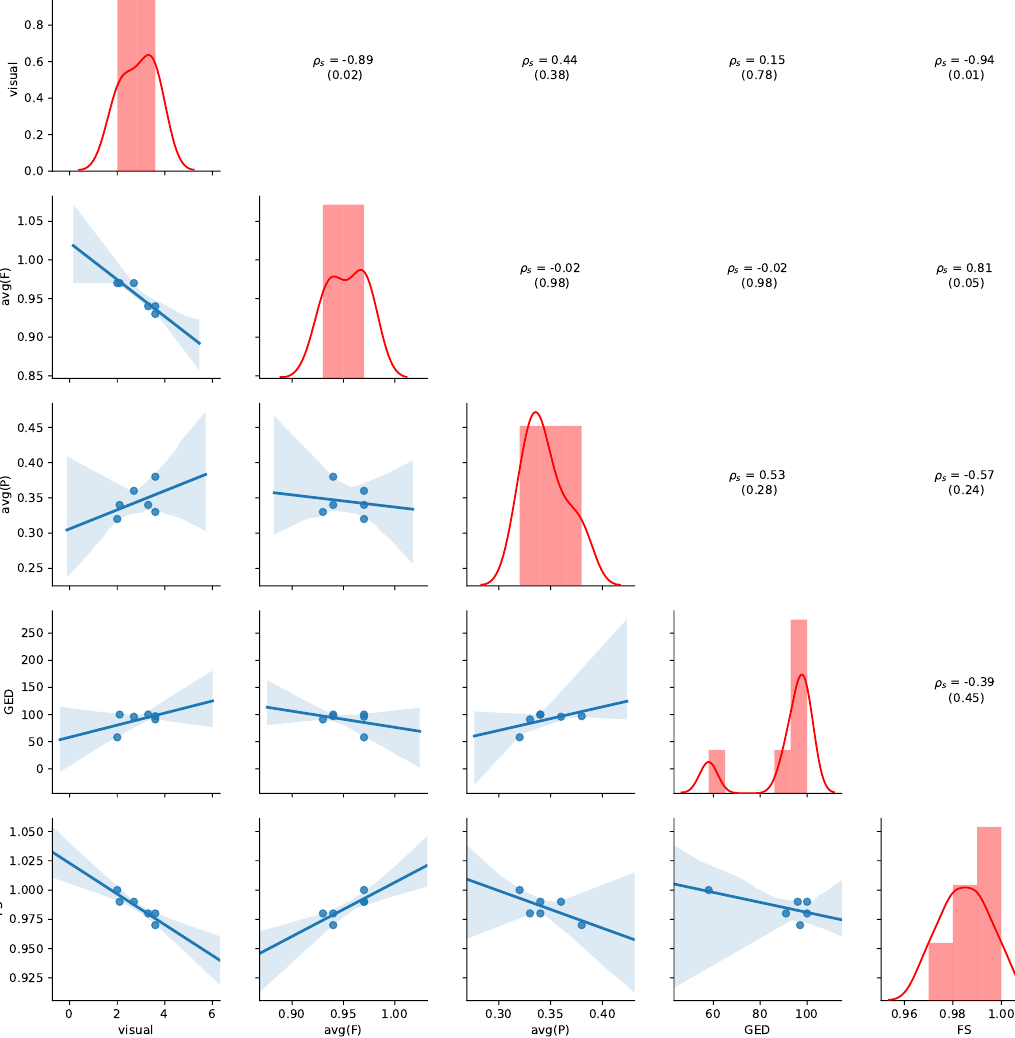
Figure 6. Relation of aggregated measures for MIMIC. Based on measures reported in Table 3. Diagonal: normalized histogram and kernel density estimation of the distribution. Lower triangle: scatterplot with estimated linear regression line. Upper triangle: pairwise Spearman’s rank correlations ( ρ s ) with p